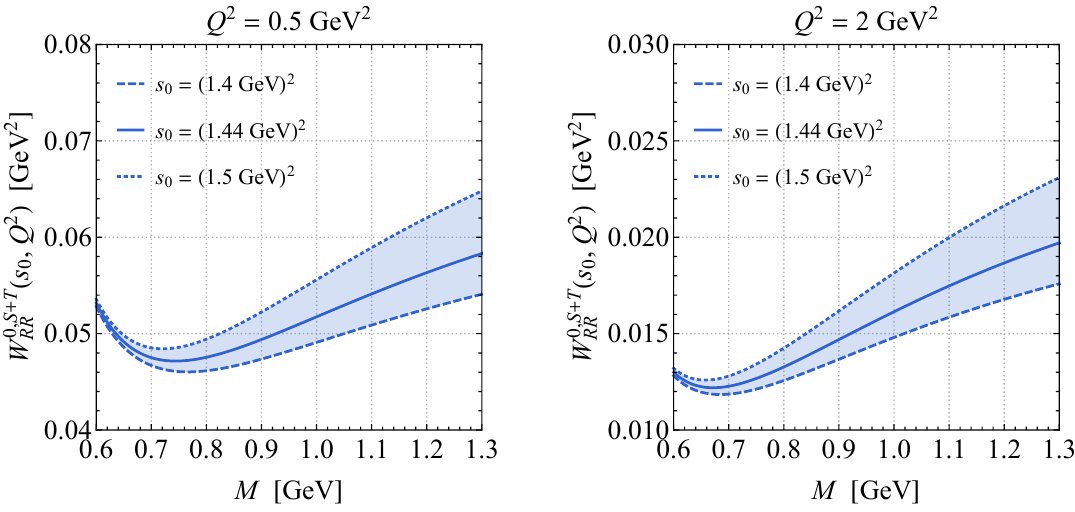
Figure 2 . Form factor W 0 ,S + T ( s 0 , Q 2 ) as a function of the Borel mass M for three values of the RR continuum threshold s 0 . The left (right) plot shows the results at Q 2 = 0 . 5 GeV 2